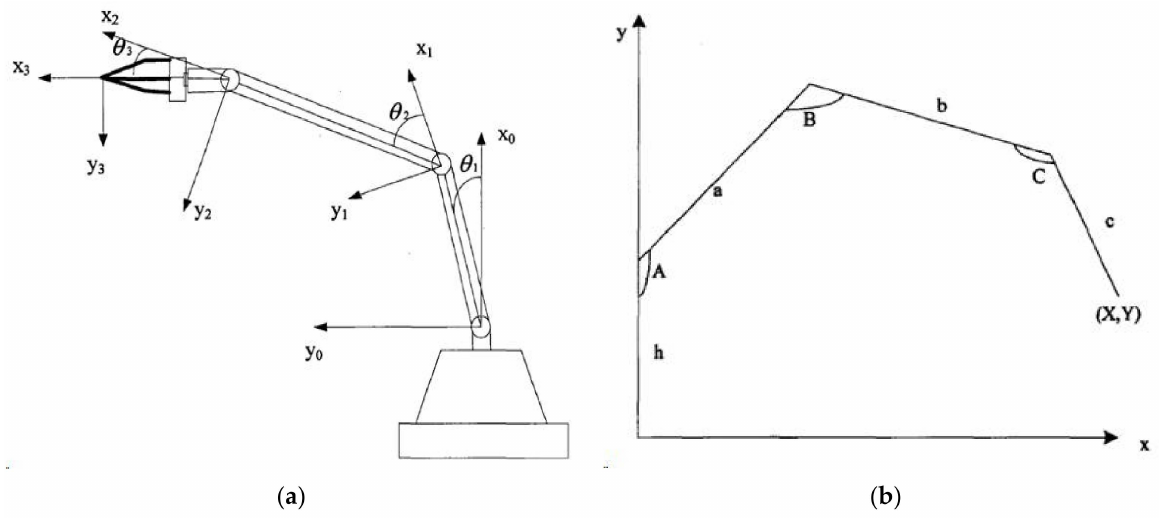
Figure 6. ( a ) The model of a robotic arm, and ( b ) a mathematical model for a robotic